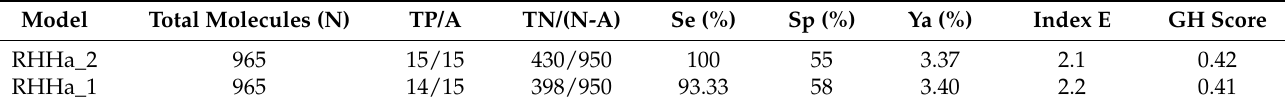
Table 2. Evaluation results of pharmacophore models P1 and P2 by decoy set.